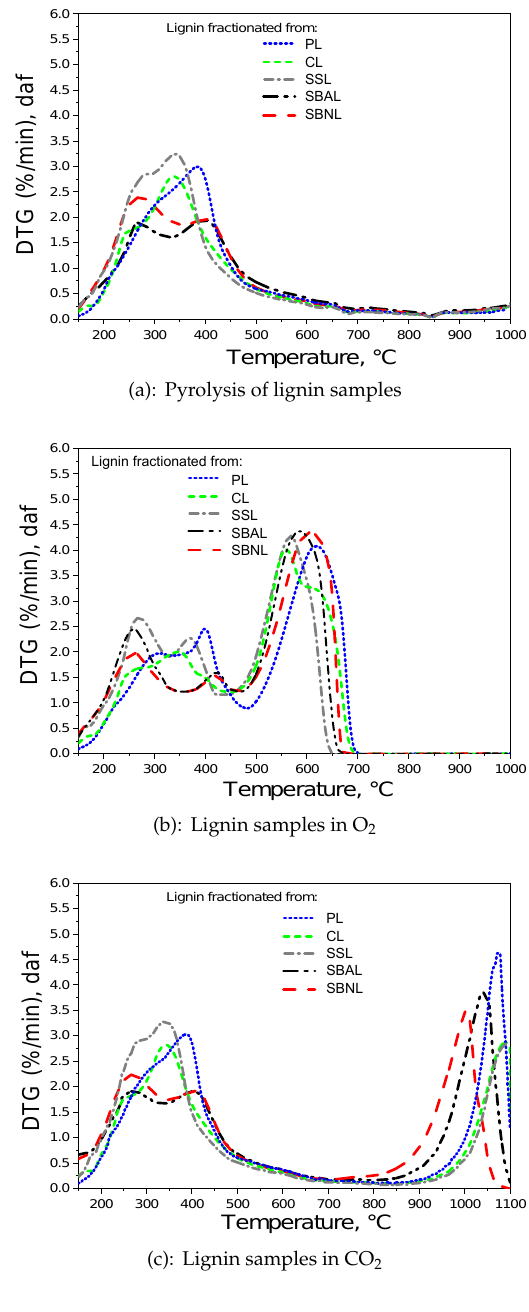
Figure 2. ( a – c ) DTG curves of lignin samples in 100% N 2 , O 2 (5% volume fraction O 2 + 95% volume fraction N 2 ) and CO 2 (20% volume fraction CO 2 + 80% volume fraction N 2 ). The abbreviations of lignin fractionated from pine sawdust (PL), cotton stalks (CL), sweet sorghum bagasse (SSL), spruce bark with (SBAL) and without acid addition (SBNL) were